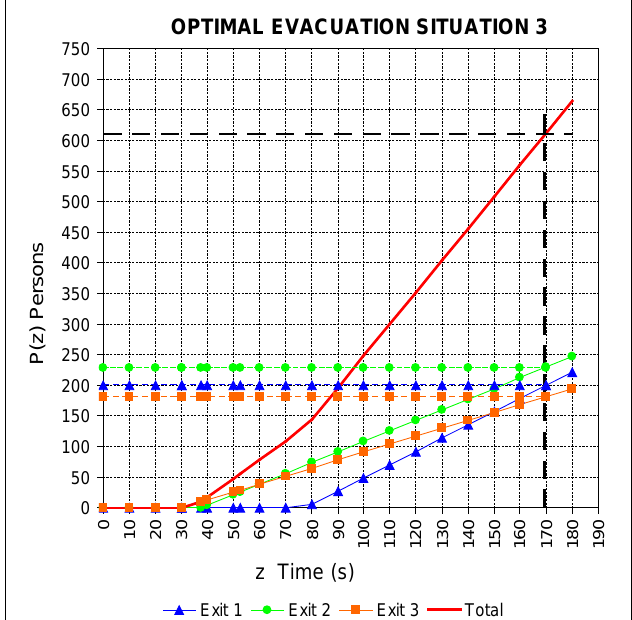
Figure 7. “Solution case